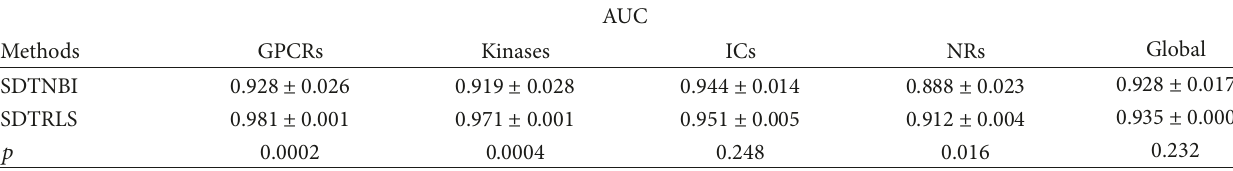
Table 5: The 𝑡 -tests results of 10-fold cross validations on 5 datasets. AUC